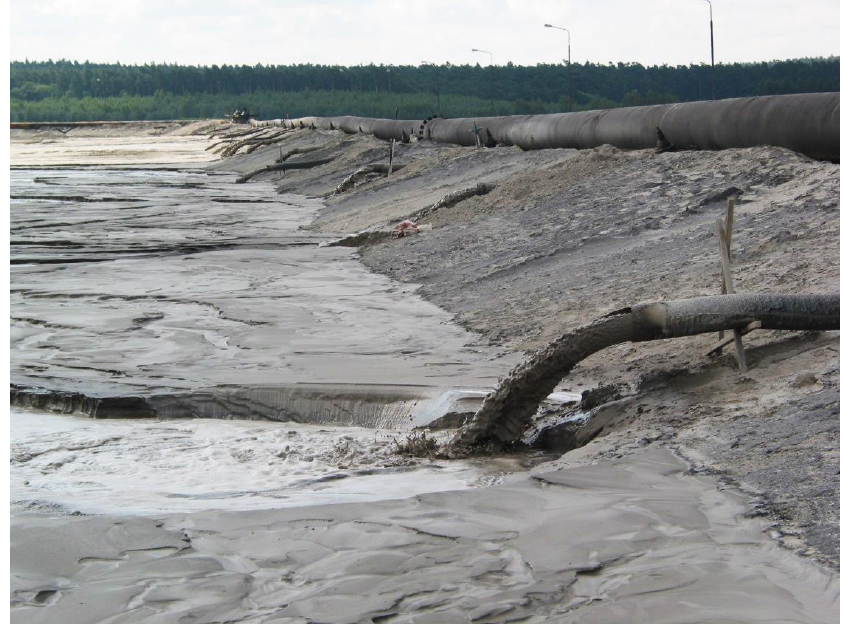
Figure 2. Waste spigotted onto the facility’s beach [13].